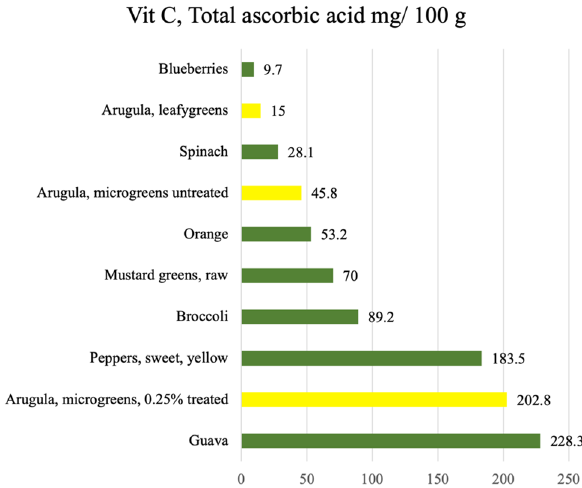
Figure 3. Vit C, Total ascorbic acid content (mg) 100 g −1 of a range of horticulture crop plants consumed raw. Reported content is that found in the raw and edible organs of the plants and was adapted from the United States Department of Agriculture database 53 (ndb.nal.usda.gov), with the exception of Arugula, microgreens, untreated 38 and Arugula, microgreens, 0.25%